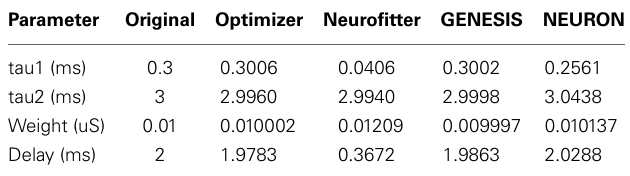
Table 2 | Comparison of the best-fitting parameter values with the original values in Use case 1.